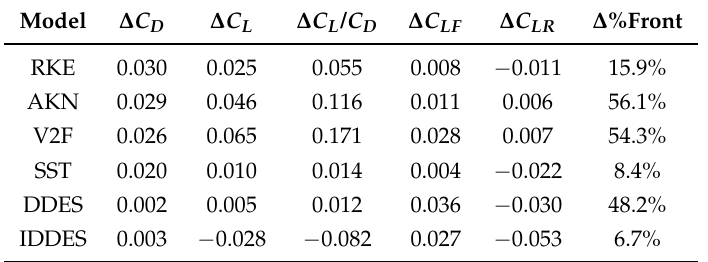
Table 3. Delta drag and lift coefficients between Case 1 and Case 2 for all models.